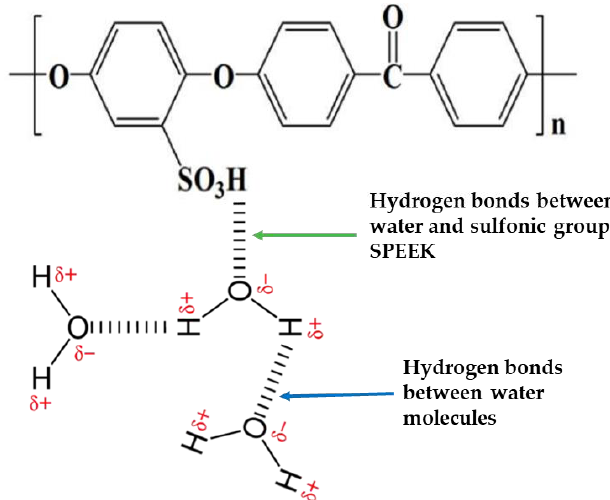
Figure 4. SPEEK chemical structure with hydrogen bonds (sulfonic group and water molecules) and hydrogen bonds (two water molecules). Modified from [75]. hydrogen bonds (two water molecules). Modified from